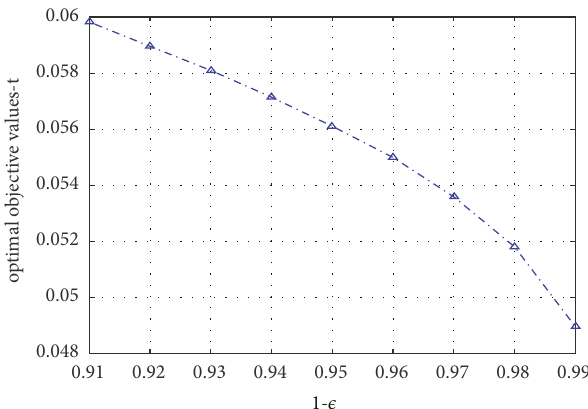
Figure 8: The optimal values generated by nominal distribution model (31) under risk parameter.